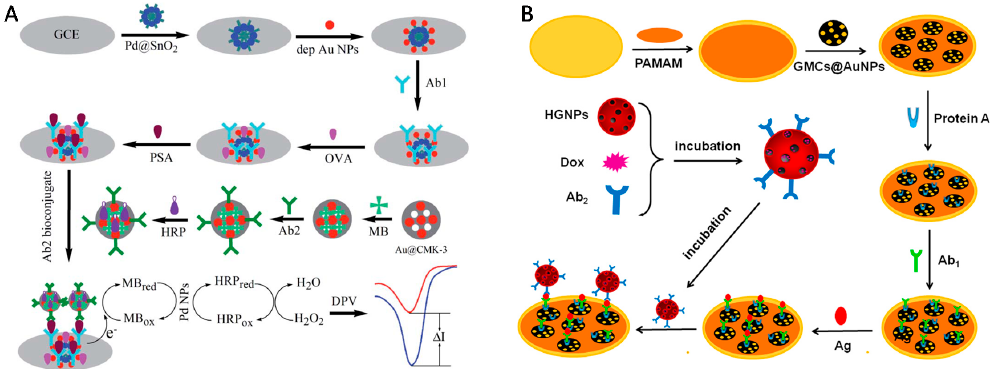
Figure 15. ( A ) Schematic diagram for the stepwise assembly of an electrochemical immunosensor for prostate-specific antigen (PSA) operating in the signal amplification strategy using a glassy carbon electrode (GCE) successively covered with gold nanoparticles (AuNPs) deposited onto flower-like SnO 2 anchored with palladium NPs (Pd@SnO 2 ), Ab 1 antibody, ovalbumin (OVA), the PSA target, and the bioconjugate in the form of CMK-3 with AuNPs, horseradish peroxidase (HRP) and methylene blue (MB) (reproduced from [256]). ( B ) Fabrication procedure for penicillin binding protein 2 a (PbP2a) immunosensor based on gold electrode covered with polyamidoamine (PAMAM), AuNPs decorated graphitized mesoporous carbon (GMC), protein A and Ab 1 antibody, the antigen (Ag) and the nanocarriers made of hollow gold nanospheres (HGNPs) incubated with the second antibody (Ab 2 ) and doxorubicin (Dox)(reproduced from [254]).